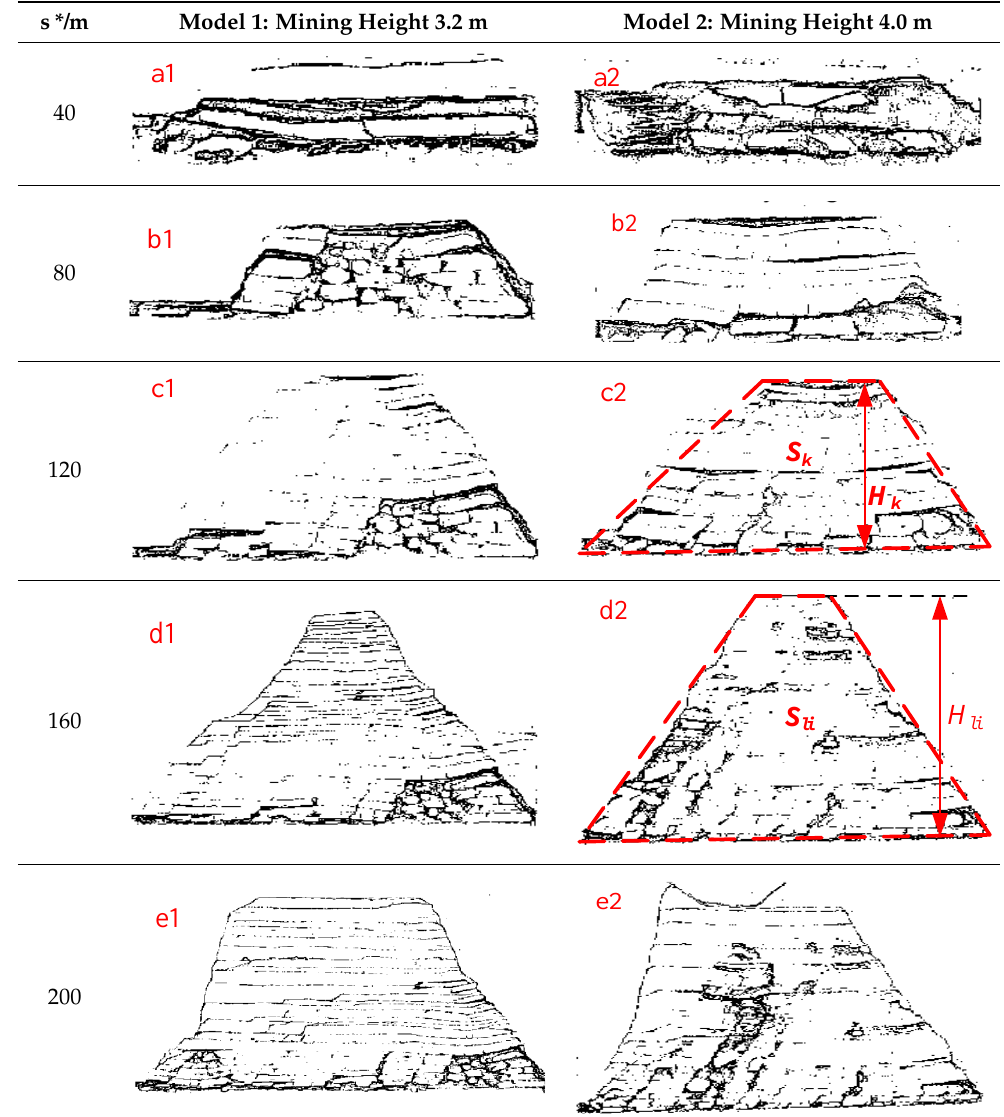
Figure 4. Analysis method flow and partial results of fractal characteristics and evolution law of overlying fissures. Table 4. Extraction of overlying rock fracture network with different mining heights.